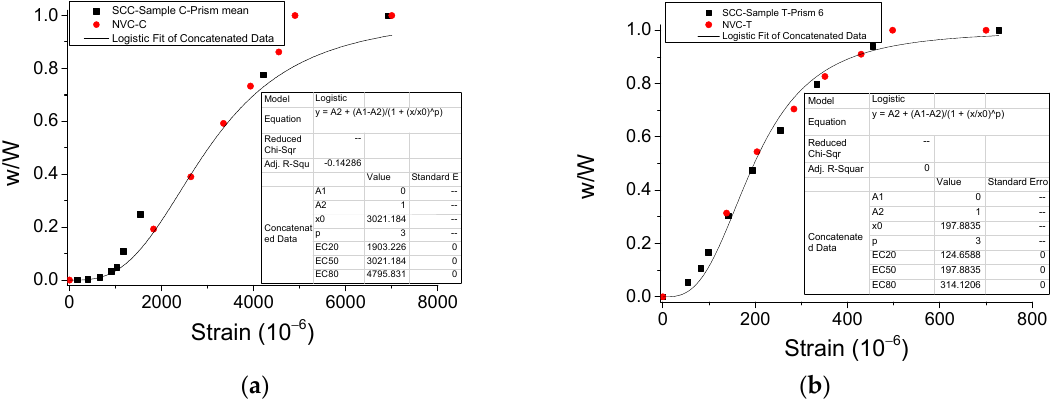
Figure 14. Typical experimental results of stress-strain curves of NVC considering the cycle number from literature. ( a ) Compressive case [19] and ( b ) tensile case [20].